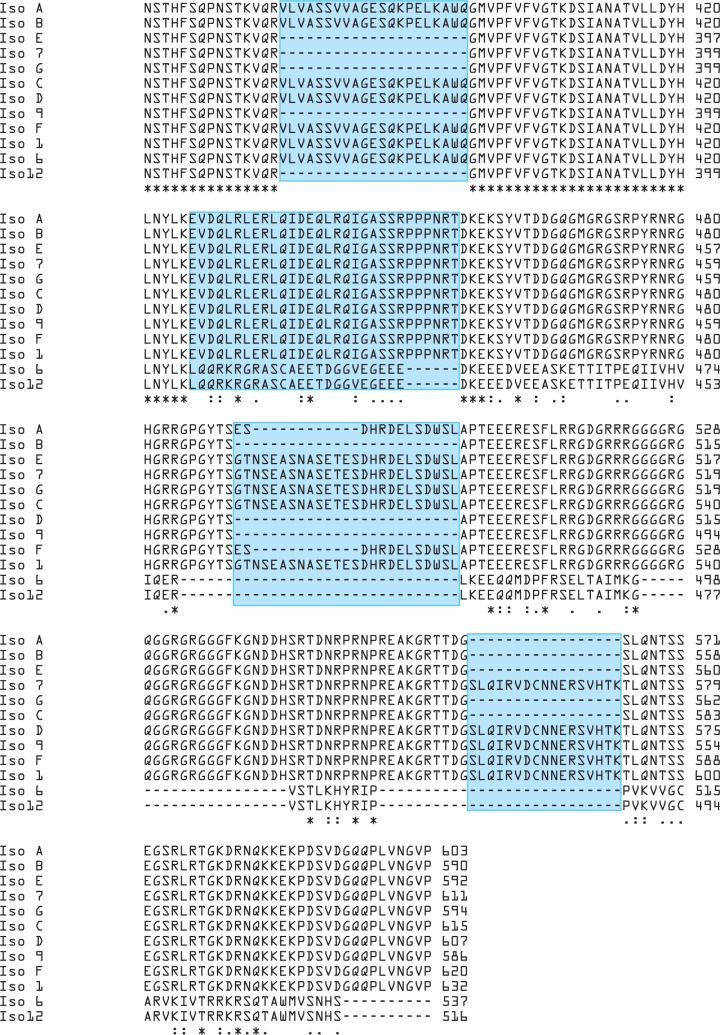
Sequence alignment of 12 known isoforms of human FMRP.Partial alignment result is shown to compare the differences. N-terminus sequences are identical among these isoforms. Box in blue indicates the region amplified by various sets of primers, asterisk represents identical residues among all isoforms, and dot/colon shows similarity of residues.